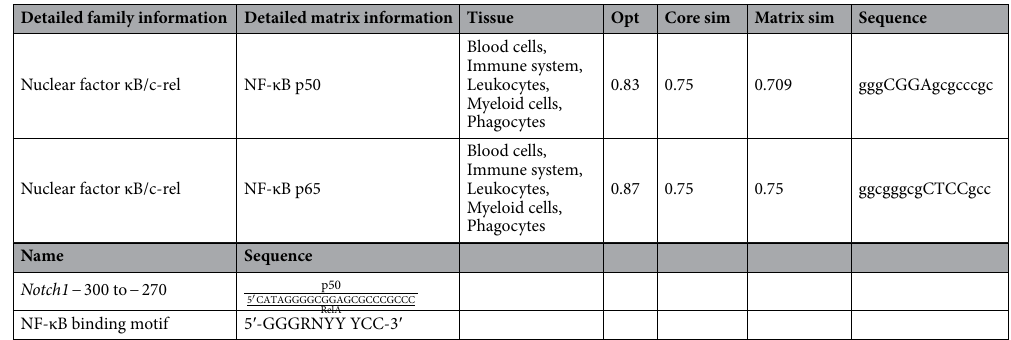
Table 1. In silico prediction of RelA and p50 as binding proteins for the Notch1 − 300 to − 270 sequence. Opt, represents optimized threshold; Core sim, core similarity; Matrix sim, matrix similarity. Nucleotides in capital letters denote the core sequence by MatInspector.